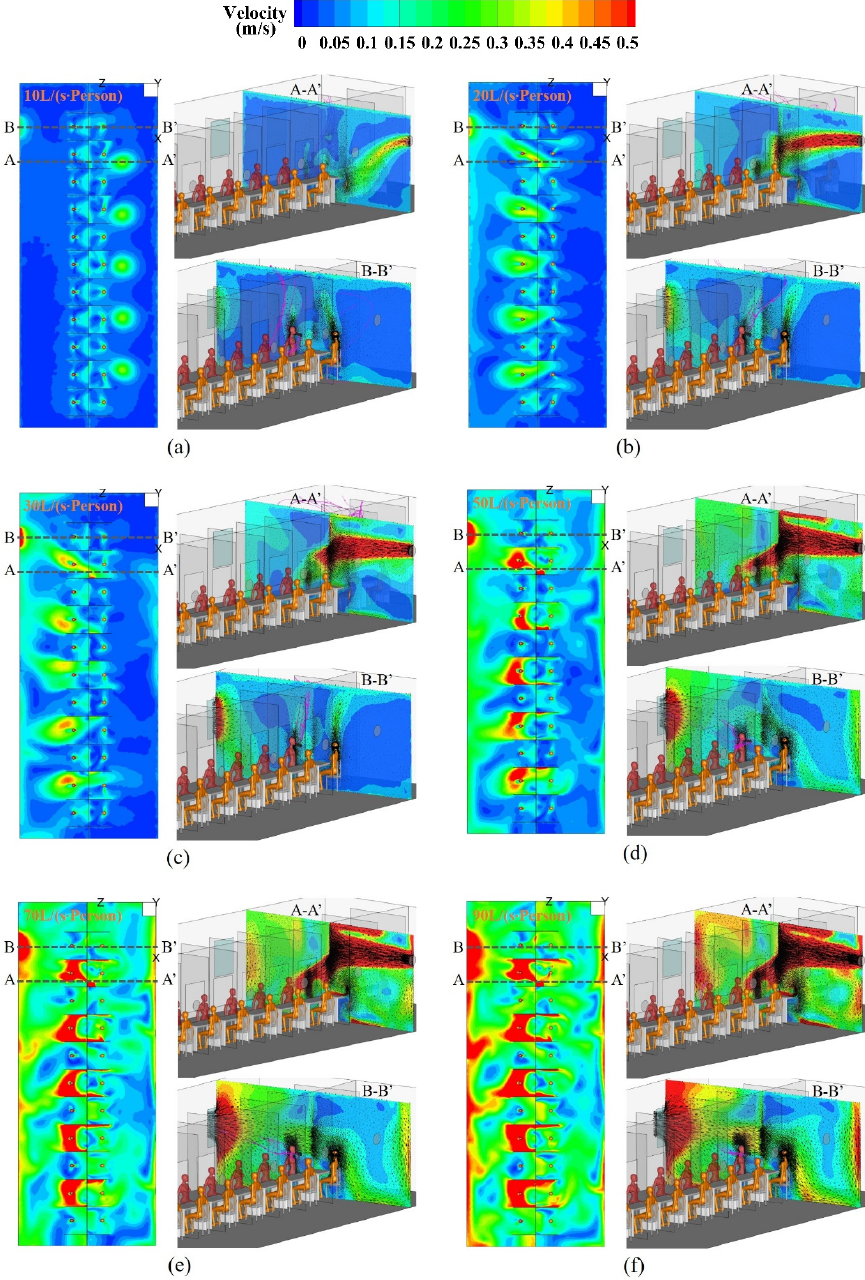
Figure 7. Airflow patterns at the planes of y = 1.1 m, x = 1.09 m, and x = 2.25 m under the SEFV with different ventilation rates: ( a ) 10 L/(s · Person); ( b ) 20 L/(s · Person); ( c ) 30 L/(s · Person); ( d ) 50 L/(s · Person); ( e ) 70 L/(s · Person); ( f ) 90 L/(s · Person).